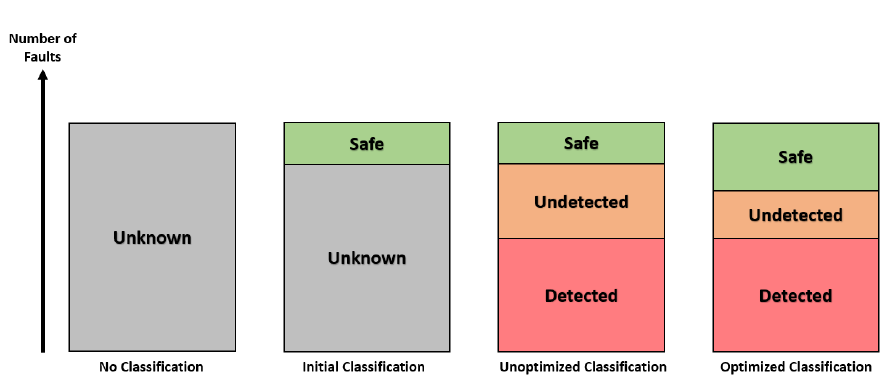
Figure 1. Hardware fault classification